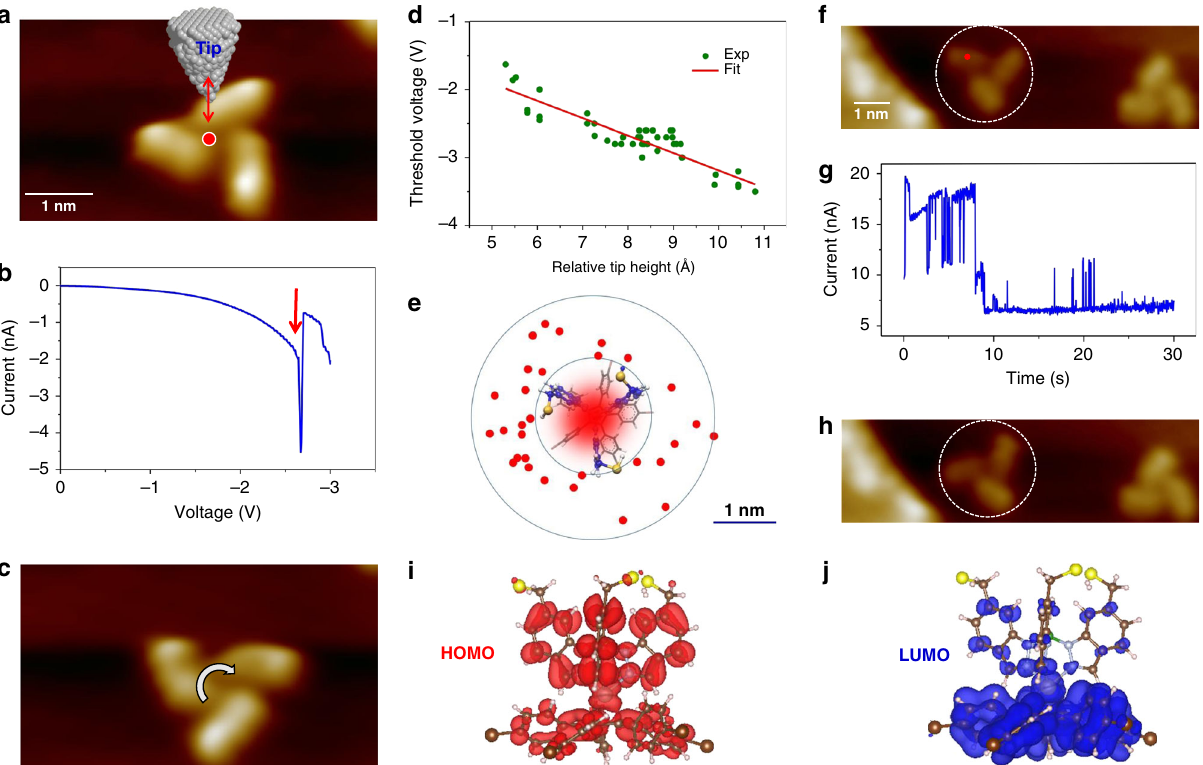
Fig. 4 STM tip-induced rotations. a The tip is positioned above the center of a propeller (red dot) for a threshold electric fi eld measurement. The red arrow indicates variation of tip heights in successive measurements. b The I – V plot shows a sudden change of current indicated with a red arrow, from which the threshold bias for rotation is determined. c STM image after the manipulation shows the rotated propeller. [Tip set point parameters for rotation: V t = − 2.0 V, I = 4 × 10 − 10 A. Imaging parameters: 5.4 × 3.0 nm 2 area, V = − 2.0 V, I = 75 pA]. d Threshold voltage has a linear relationship with tip height. t t t e The red dots indicate the tip positions for the threshold voltage measurement at the side of the molecule. f The tip is positioned above the red dot for IET induced rotation. g The abrupt changes in the current are caused by the movement of the propeller blades. h The propeller is rotated anti-clockwise after the IET manipulation. [Tip set point parameters for rotation: V t = 0.6 V, I t = 2 nA. Imaging parameters: 10.4 × 3 nm 2 area, V t = − 2.0 V, I t = 46